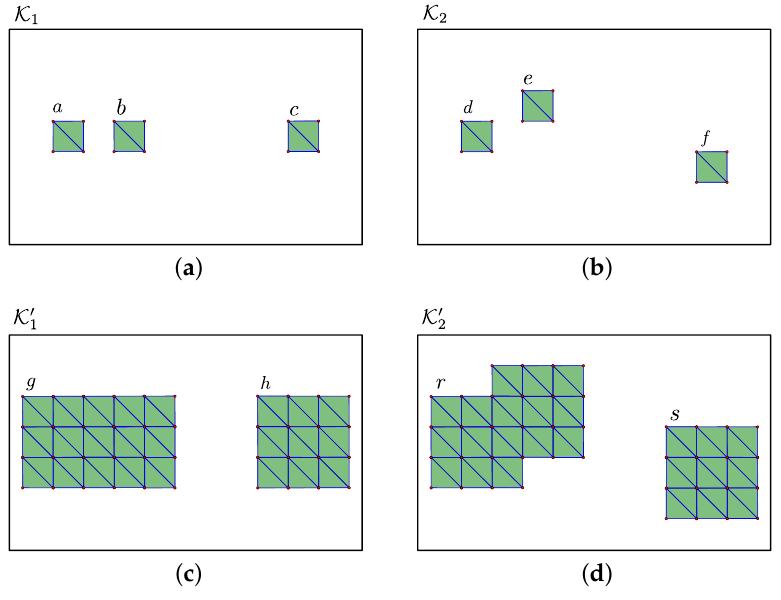
Figure 4. The simplicial complexes K 1 and K 2 in ( a ), ( b ), respectively, correspond to the triangulation of objects at two discrete time steps. The simplicial complexes K (cid:48) correspond to the triangulation of an enlargement of objects at the same two discrete time steps. Each connected component is labelled with a unique